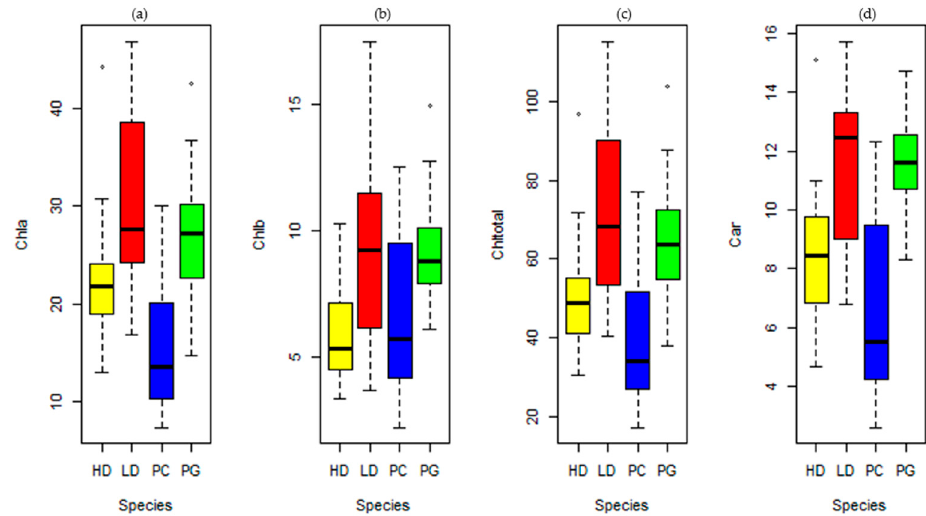
Figure 5. Boxplot of leaf-level functional traits Photosynthetic pigments: ( a ) Chla ( µ g cm − 2 ) = chloro- phyll a content; ( b ) Chlb ( µ g cm − 2 ) = chlorophyll b content; ( c ) Chl ( µ g cm − 2 ) = total chlorophyll content; and ( d ) Car ( µ g cm − 2 ) = carotenoid content; where the species are:HD (yellow) = Hovenia dulcis ; LD (red) = Luehea divaricata ; PC (blue) = Psidium cattleianum ; PG (green)= Psidium guajava . * Indicates outliers.